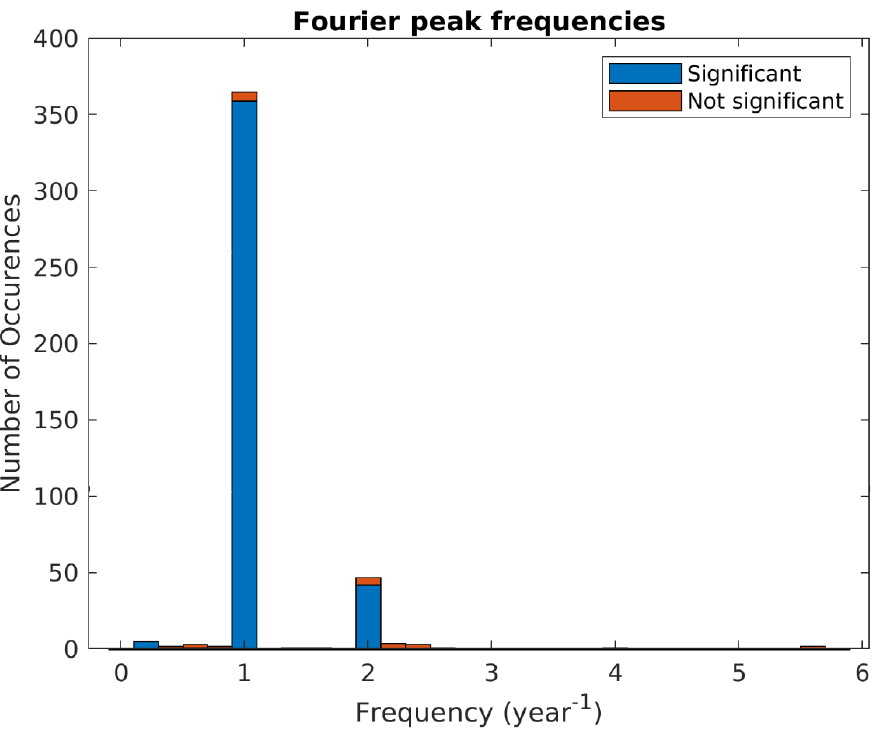
Figure 12. Histogram of the primary peak Fourier frequencies for the Longreach range-azimuth cells. Significant peaks are shown in blue, and peaks that are not significant are shown in red.